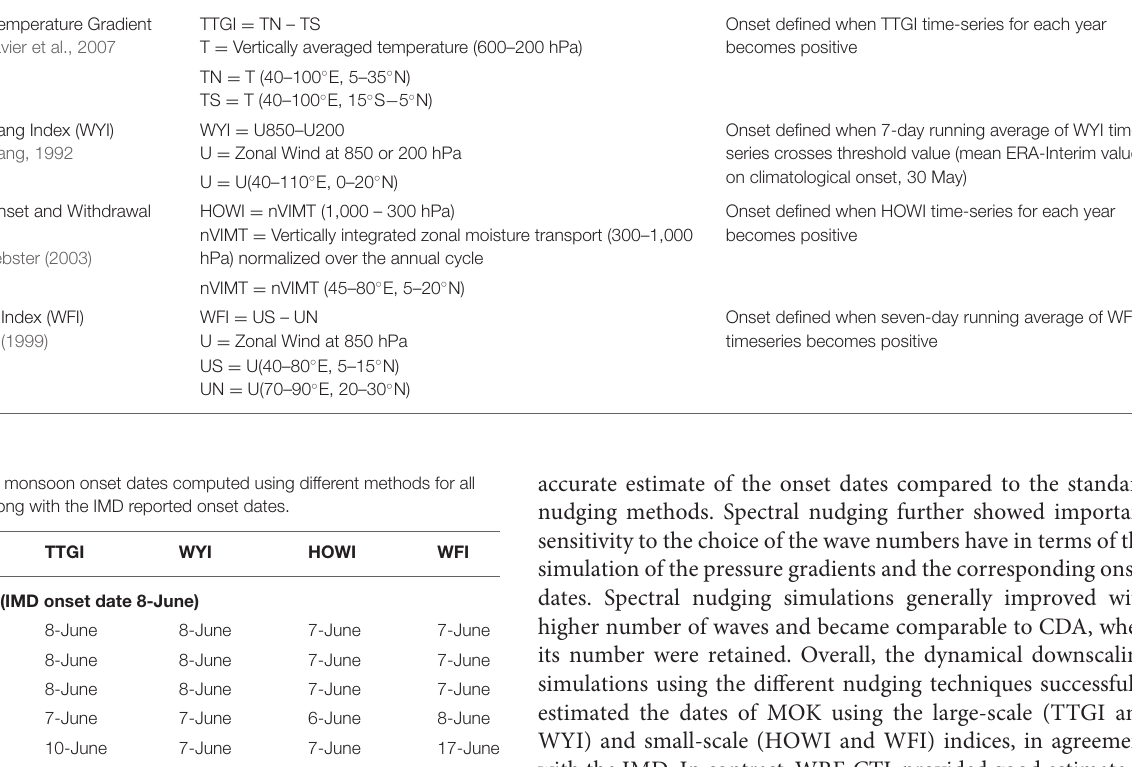
TABLE 1 | Details of the monsoon onset indices adopted in the study. Index and eeference Methodology